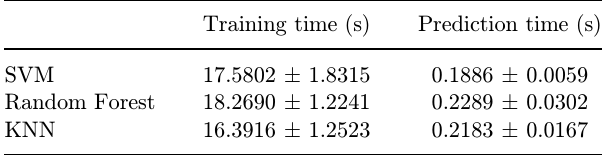
Table 4. Time performance of di®erent classi¯cation